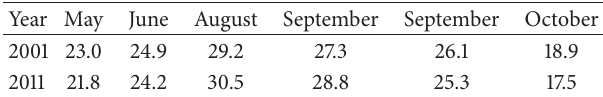
Table3:AveragesurfacetemperaturedistributioninDongtingLake in 2001 and 2011 (unit: ∘